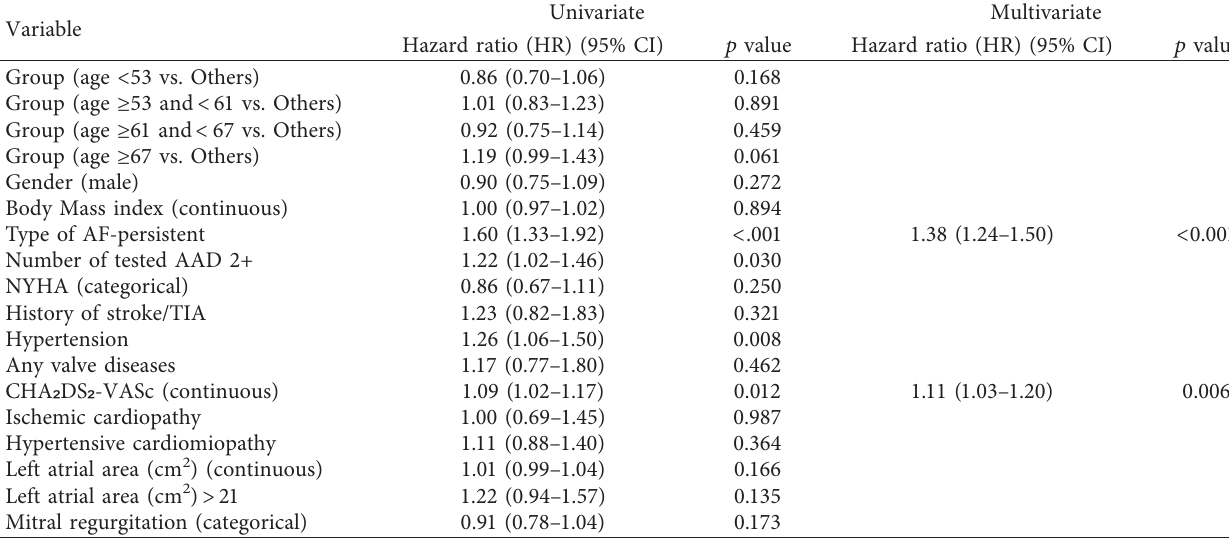
Table 4: Univariate analysis to investigate AF predictors. Baseline characteristics resulting in differences between groups ( p < 0 . 10) were tested and are